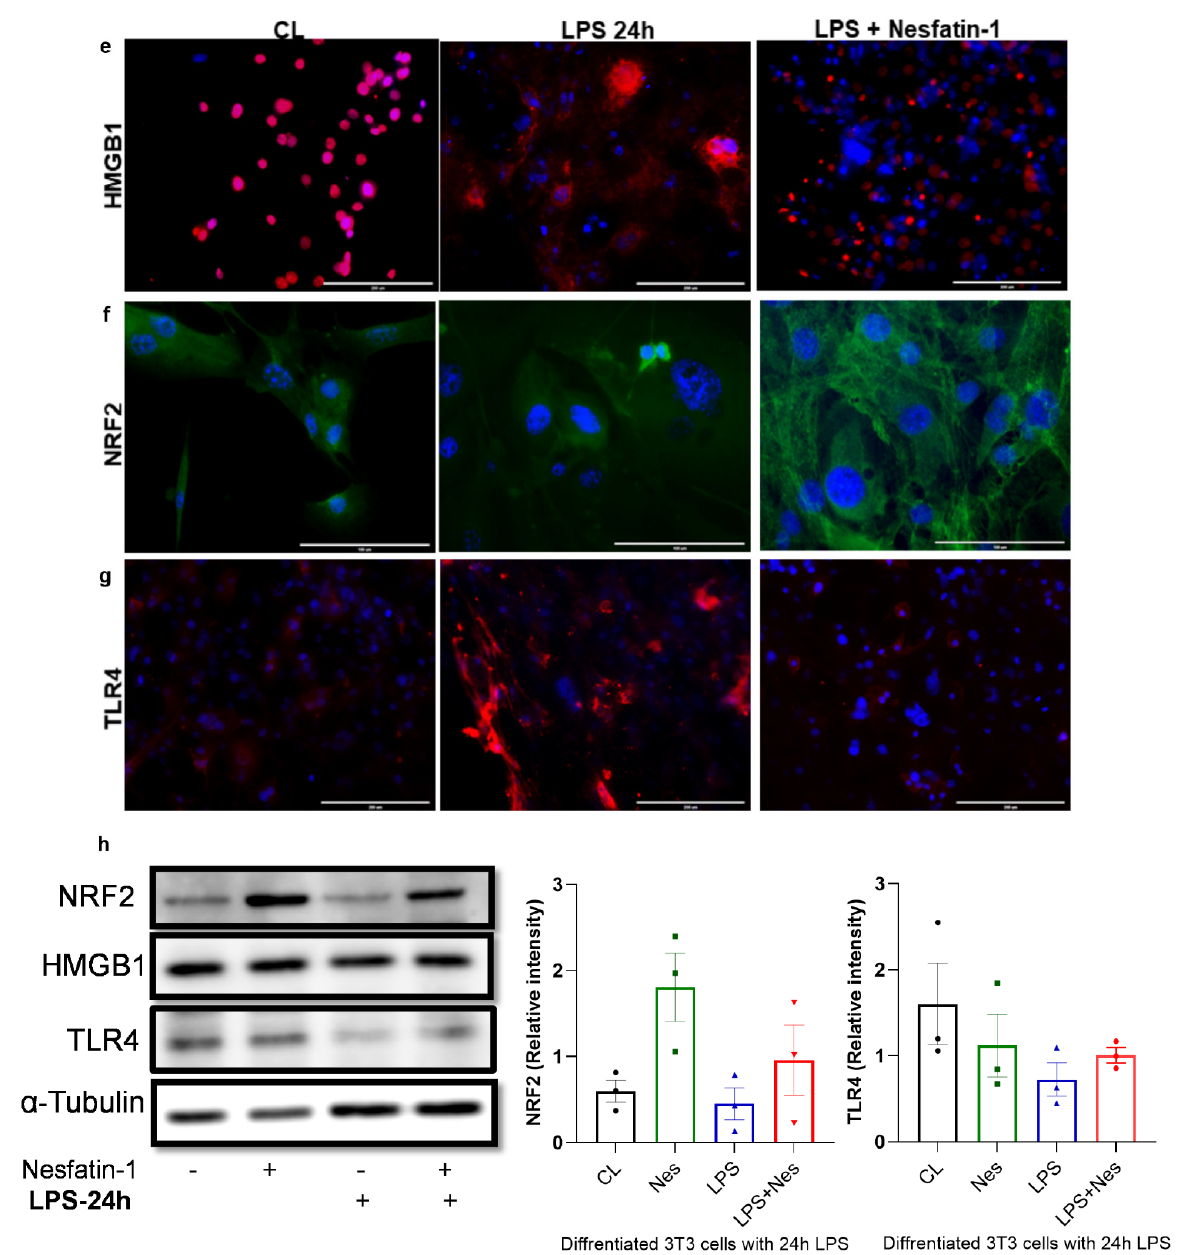
Figure 3. Nesfatin-1 protects against lipopolysaccharide (LPS, also known as endotoxin) induced inflammation. ( a ) mRNA levels of Tnfa, Il6, Il1b, Mcp1, and Hmgb1 were determined in differentiated 3T3-L1 cells with and without nesfatin-1 treatment, as well as with and without 5 h LPS treatment and the combination of the two treatments. The mRNA expression of NRF2 and TLR4 were measured following a 24 h LPS treatment. Data are presented as fold-change (mean ± SEM) in transcript. The experiments were repeated in three independent cultures. One-way ANOVA; * p < 0.05; ** p < 0.01; *** p < 0.001; p ****<0.0001. Immunofluorescence staining of ( b ) TNFa (red) and ( c ) NF-kB (green) in differentiated 3T3-L1 cells with and without nesfatin-1 treatment, as well as with and without 1 h LPS treatment and the combination of the two treatments. DAPI (blue) was utilized to stain the nuclei, arrows indicate presence of NF-kB in the nuclei. Photos were taken at 40 × magnification on EVOS fluorescence microscope, scale bar 100 µ m. ( d ) p-NF-KB, total NF-kB, and IKB protein levels were determined by western blot analysis in differentiated 3T3-L1 cells with and without nesfatin-1